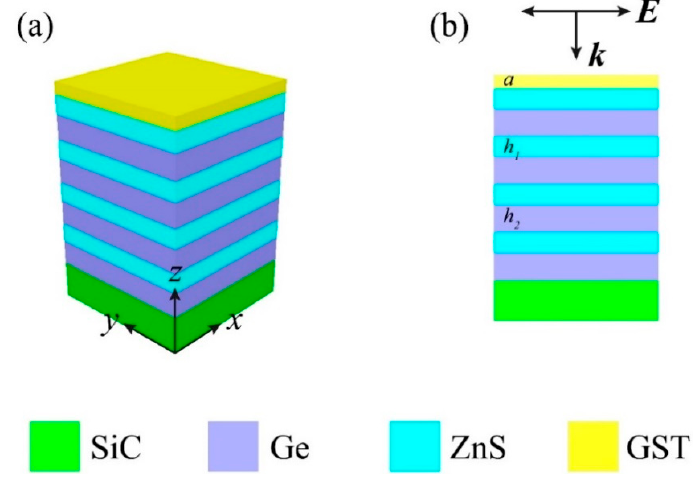
Figure 1. ( a ) Schematic of the initial structure; ( b ) cross ‐ section view of the proposed absorber.